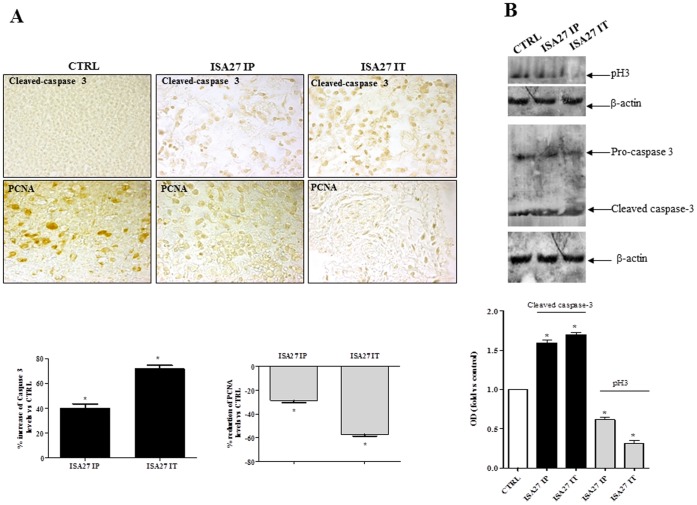
ISA27 inhibits cell proliferation and induces apoptosis in tumor tissues.14 days from starting treatment, tumors were harvested from mice of different ISA27 treatment groups (IP = intraperitoneal treatment; IT = intratumor treatment) and processed for histological and Western blotting analysis. A) Histological analysis: apoptosis and cell proliferation were evaluated by analysis of cleaved caspase 3 and PCNA levels by immunohistochemistry in paraffin embedded sections of tumors. Upper panel shows representative images of immunohistochemistry analysis. ISA27-treated tumors show increased cleaved caspase 3 levels and reduced cell proliferation. Cleaved caspase 3 and PCNA levels in tumors were quantified from digital images. Results are shown in graph as percent of cleaved caspase 3 and PCNA expression respect to controls (*P<0.05 vs control). B) Western blotting analysis: apoptosis and cell proliferation were evaluated by analysis of cleaved caspase 3 and phosphorylated histone H3 (pH3) levels by Western blotting in whole lysates of tumors using specific antibodies. Densitometric analysis shows that ISA27 induced a significant increase in cleaved-caspase-3 levels and a significant reduction in pH3 levels (*P<0.05 vs control).